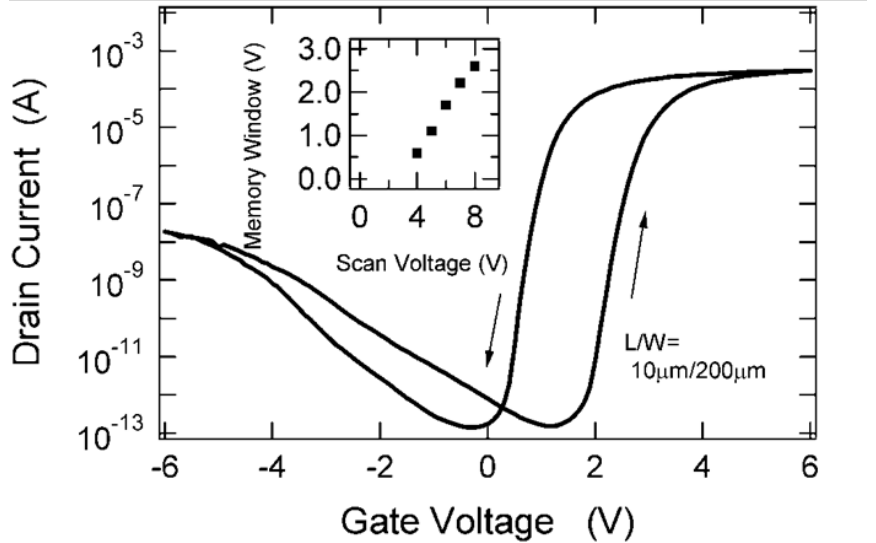
= ±4.0, ±5.0, ±6.0, ±7.0 g = ±8.0 V. Reproduced from [15] with g